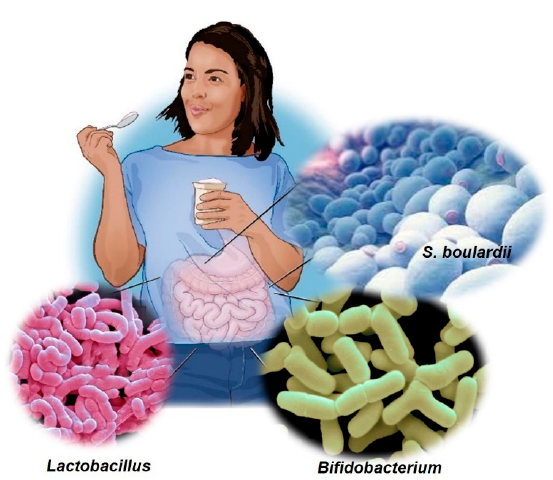
Figure 2. Probiotics are made of both bacteria and yeast. Common probiotic bacteria can include Lactobacillus and Bifidobacterium . The most common yeast found in probiotics is Saccharomyces boulardii [22].